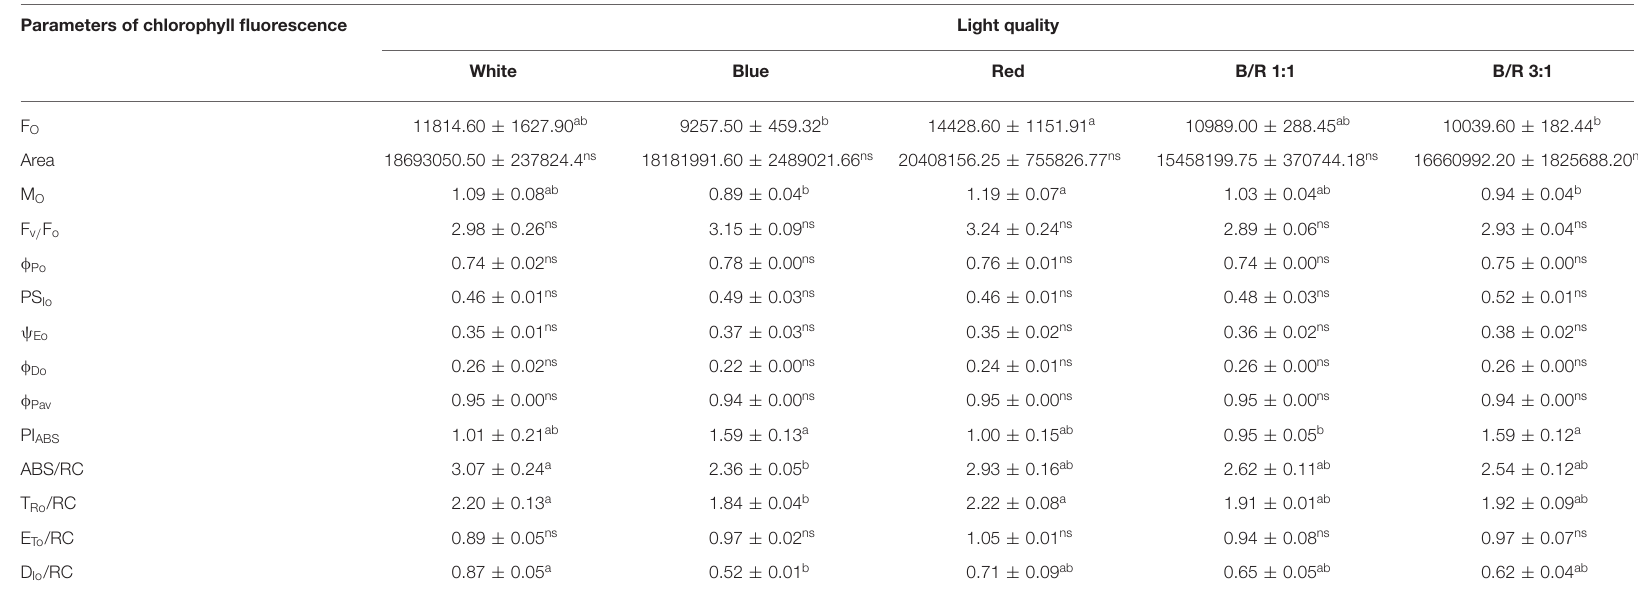
TABLE 5 | Initial fluorescence (F O ); area between OJIP curve and the line F = F M (Area); maximum fluorescence (F m ); effective quantum yield of photochemical energy conversion (F v /F o ); maximum quantum yield of primary photochemistry ( φ Po ); quantum yield, i.e., the probability, at t = 0, that a trapped exciton moves an electron into the electron transport chain beyond Qa − (PS Io ); quantum yield of electron transport ( ψ Eo ); quantum yield of energy dissipation in the form of heat ( φ Do ); mean quantum yield of primary photochemistry ( φ Pav ); photosynthetic performance index (PI ABS ); specific absorption flux per reaction center (ABS/RC); maximum exciton capture rate of PSII (T Ro /RC); electron transport flux (in addition to Qa) per reaction center at t = 0 (E To /RC); and specific dissipated energy flux at the level of the antenna chlorophylls (D Io /RC) in Brosimum gaudichaudii seedlings grown in vitro under different LED spectra for 50 days.